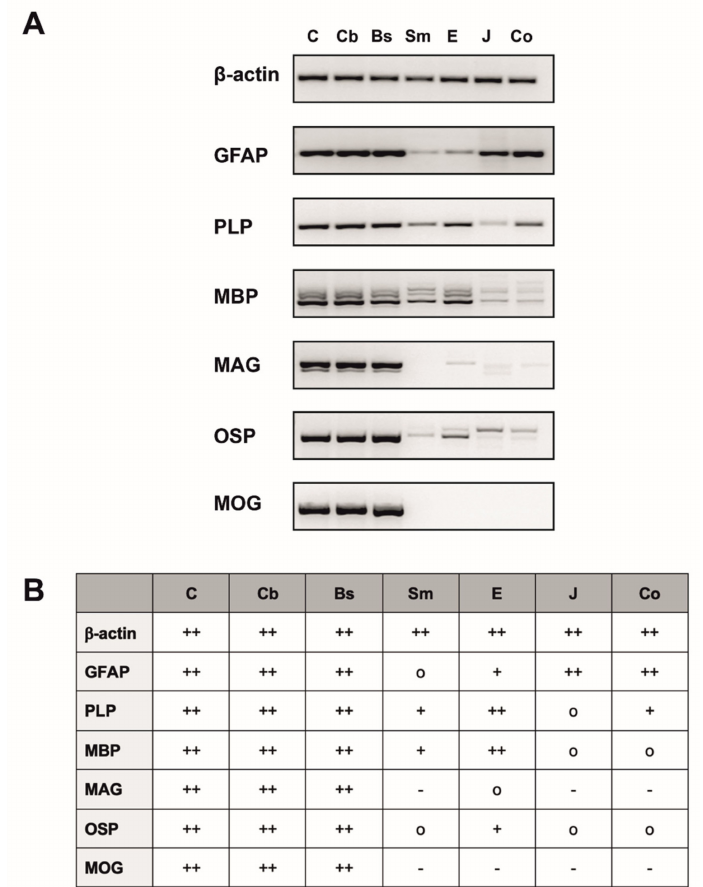
Figure 1. RT-PCR analysis for β -actin, glial fibrillary acidic protein (GFAP), proteolipid pro- tein (PLP), myelin basic protein (MBP), myelin associated glycoprotein (MAG), oligodendrocyte- specific protein (OSP) and myelin oligodendrocyte glycoprotein (MOG) of n = 6 mice. ( A ) Overview of different expression levels of the examined markers with β -actin used as housekeeping gene, shown by one representative mouse. ( B ) Table summarizing the PCR results of six mice and showing the expression profile of the different tissues investigated with + indicat- ing a “high expression”, + indicating a “medium–low expression”, o indicating a “very low expression” and–indicating no expression. Since results from individual mice did not differ, data were pooled. C: Cerebrum; Cb: Cerebellum; Bs: Brain stem; Sm: Skeletal muscle (M. tib- ialis anterior); E: Esophagus; J: Jejunum; Co: Colon ascendens; GFAP: Glial fibrillary acidic pro- tein; PLP: Proteolipid protein; MBP: Myelin basic protein; MAG: Myelin-associated glycoprotein; OSP: Oligodendrocyte-specific protein; MOG: Myelin oligodendrocyte